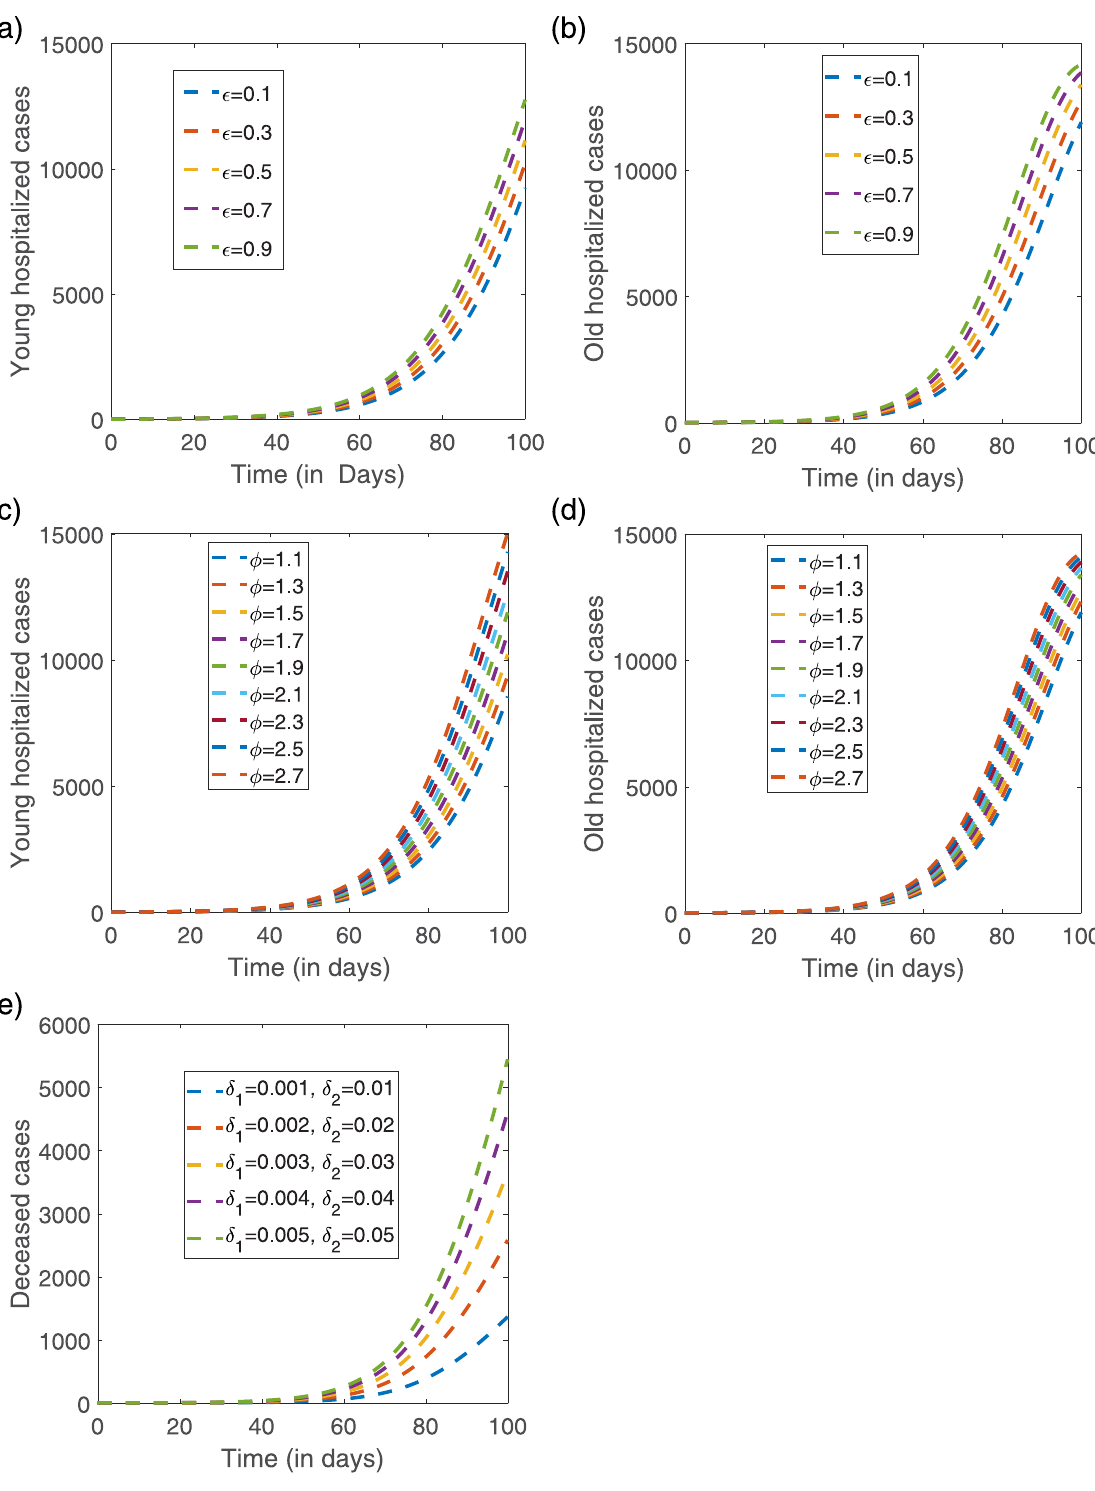
Fig 10. Deterministic model simulations.